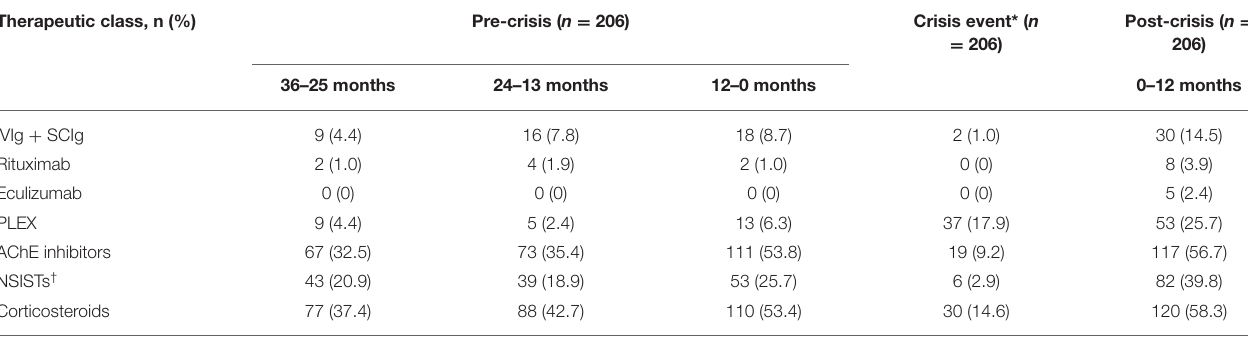
TABLE 5 | Patient distribution within each drug class for the crisis event subgroup. Therapeutic class, n (%)